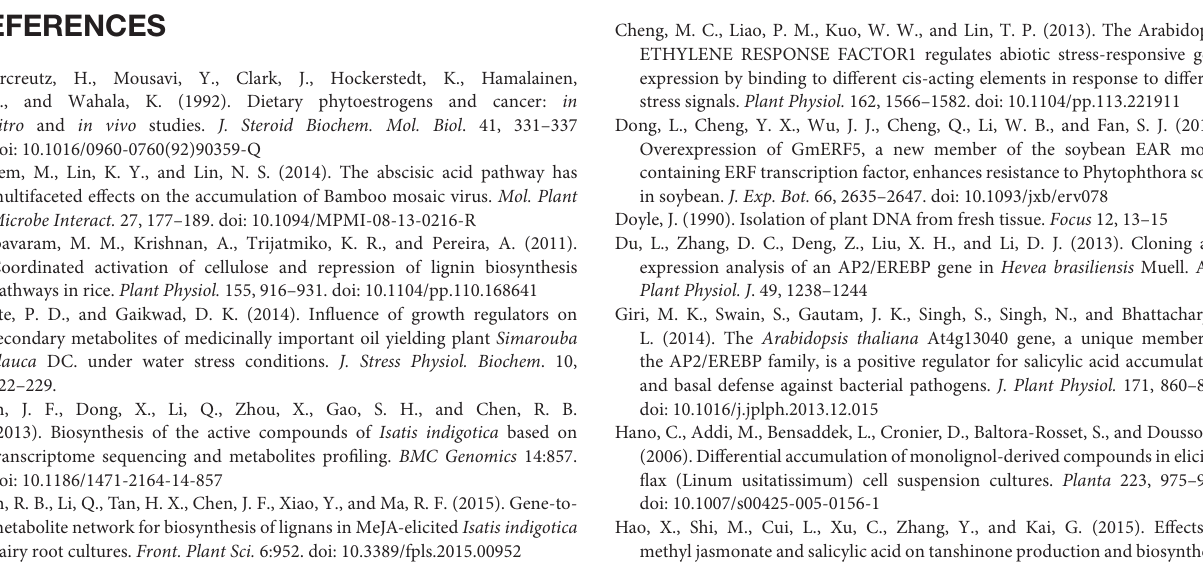
Supplementary Table S1 | PCR primers used for Ii049 isolation and vector construction. Supplementary Table S2 | Primers used in qRT-PCR. Supplementary Table S3 | Sequence data for the genes described in this